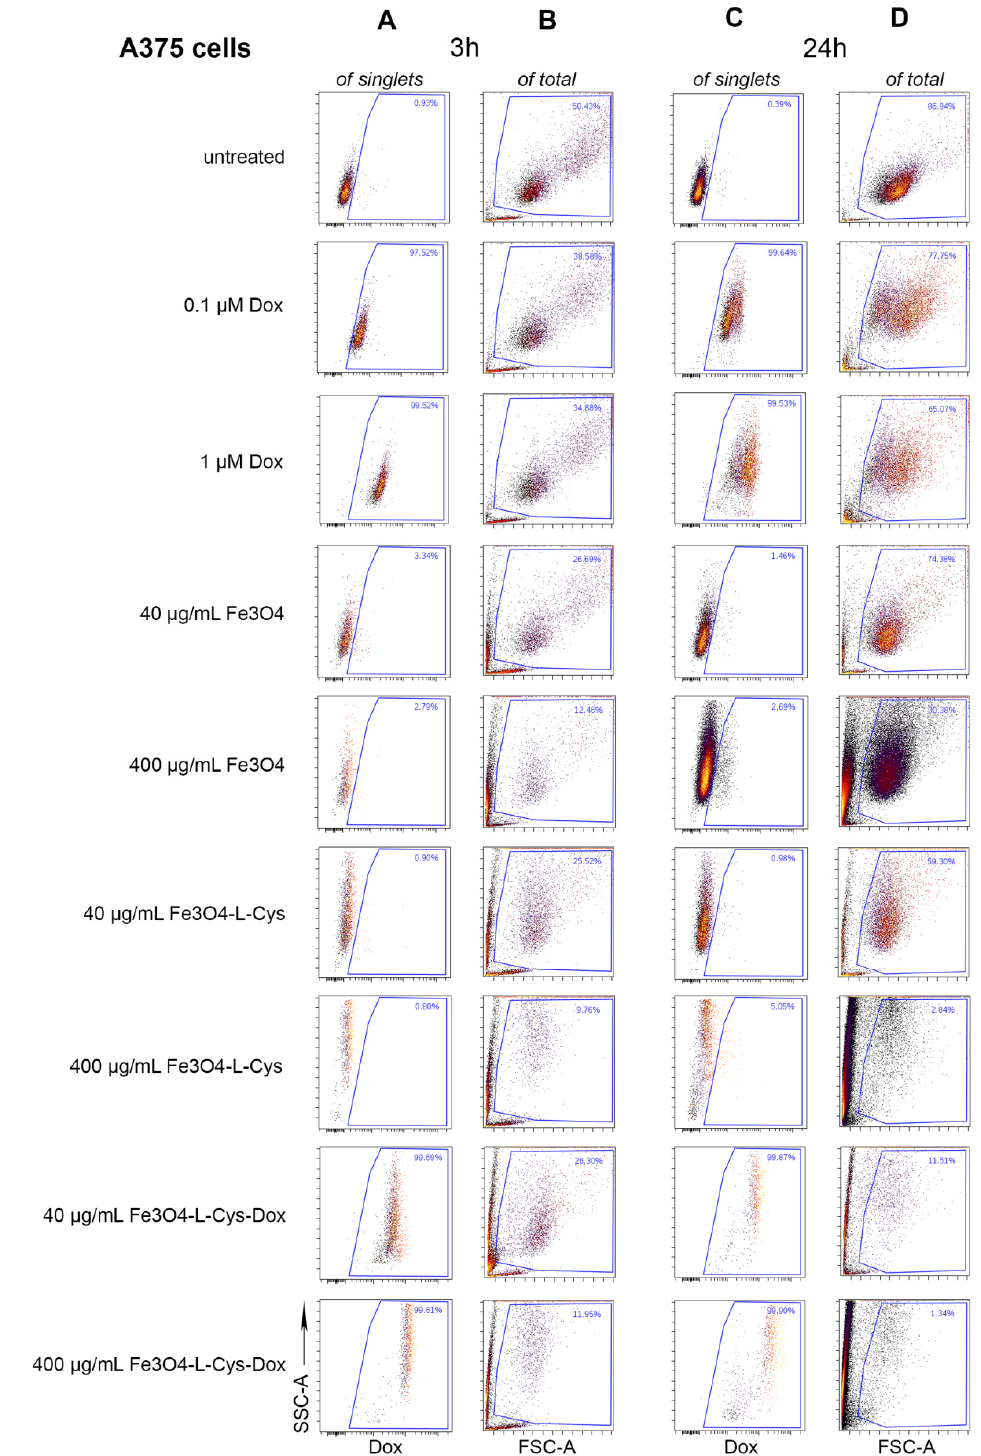
Figure 9. Flow cytometry quantification of Dox uptake by melanoma cells at 3 ( A , B ) and 24 h ( C , D ) after treatment with drug-loaded NPs versus free drug. Detection of Dox in A375 human melanoma cells ( A , C ) was measured on the Per-CP-Cy5.5 channel. Light scattering modifications of A375 cells ( B , D ) upon treatment were assessed using FSC-A/SSC-A measurements. FSC = forward-scattered light; SSC = side-scattered light.